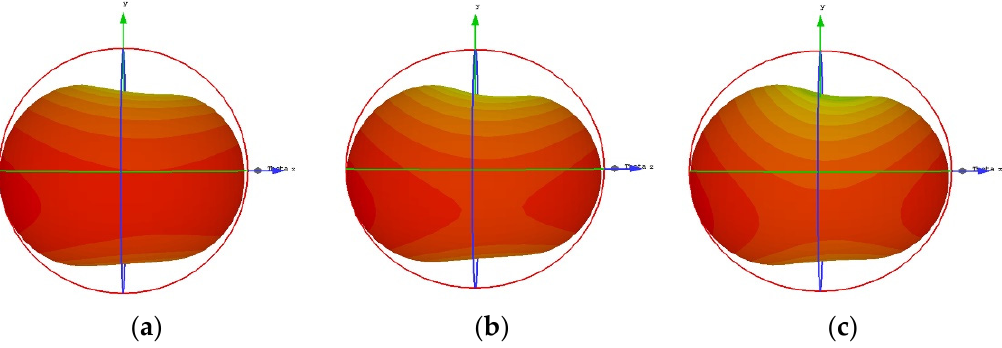
Figure 16. Simulated 3d gain at ( a ) 3.4 GHz, ( b ) 3.9 GHz, and ( c ) 4.2 GHz.